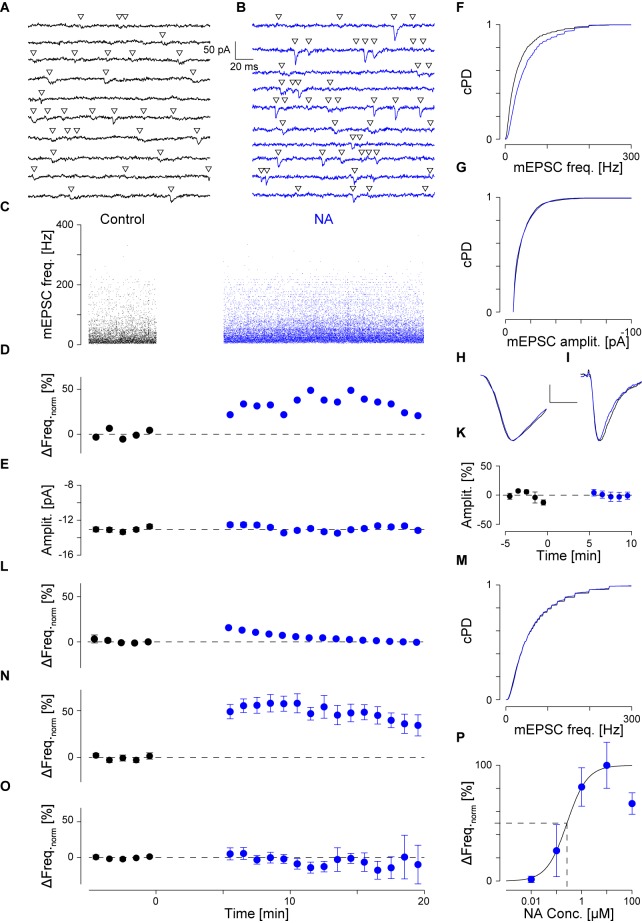
NA (10 μM) increases the mEPSC frequency without affecting the amplitude. (A) Continuous recording period (2 s) during control. Detected mEPSCs are indicated by a triangle. (B) Same as (A) but after addition of NA (blue). (C). Individual instantaneous mEPSC frequencies in a single pyramidal cell shown for the control period (t < 0 min) and after addition of NA (t = 0 min). (D) Time course of minute averages (including respective errors) of the data in (C) after normalizing for the frequency during control (black) and after NA (blue). Dashed line indicates no change. (E) Time course of minute averages of mEPSC amplitudes. (F) Cumulative probability density functions of the instantaneous frequencies during control (black) and in NA (blue). (G) Same as in (F) but for the mEPSC amplitude. (H) Average mEPSC time course during control and in NA (scale bar 4 pA and 2 ms). (I) Average time course of iEPSCs during control and with 10 μM NA (scale bar 20 pA and 20 ms). (K) Normalized minute averages of all iEPSC amplitudes before and after NA. (L) Normalized minute averages of mEPSC frequency for a non-responder. (M) Same as for (F), but the case in (L). (N,O) Overall time courses of normalized minute averages of the mEPSC frequency in responders (N) and non-responders (O), respectively. (P) Concentration-response relationship between normalized mEPSC frequency increase and NA concentration. The solid line is the best fit of a Hill equation to the data. Dashed lines indicate the EC50 value.